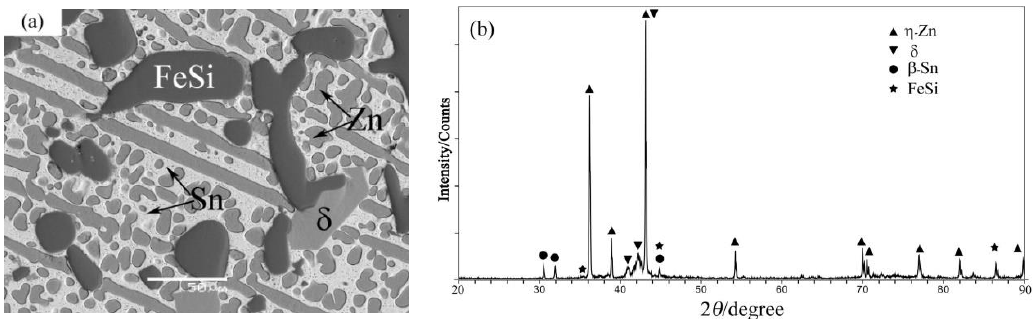
Figure 4. The microstructure ( a ) and XRD pattern ( b ) of Alloy A3.